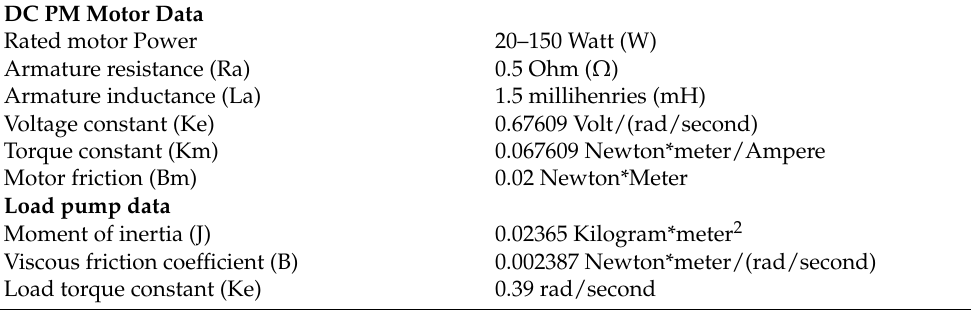
Table 5. Parameters of DCPM motor and the load pump.